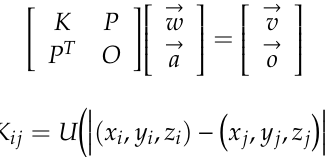
Figure 3. Initial grid shape for circular cylinder. ( a ) whole domain (side view), ( b ) surface mesh (perspective view), ( c ) around front part of the body (leading edge), ( d ) around rear part of the body (trailing edge).